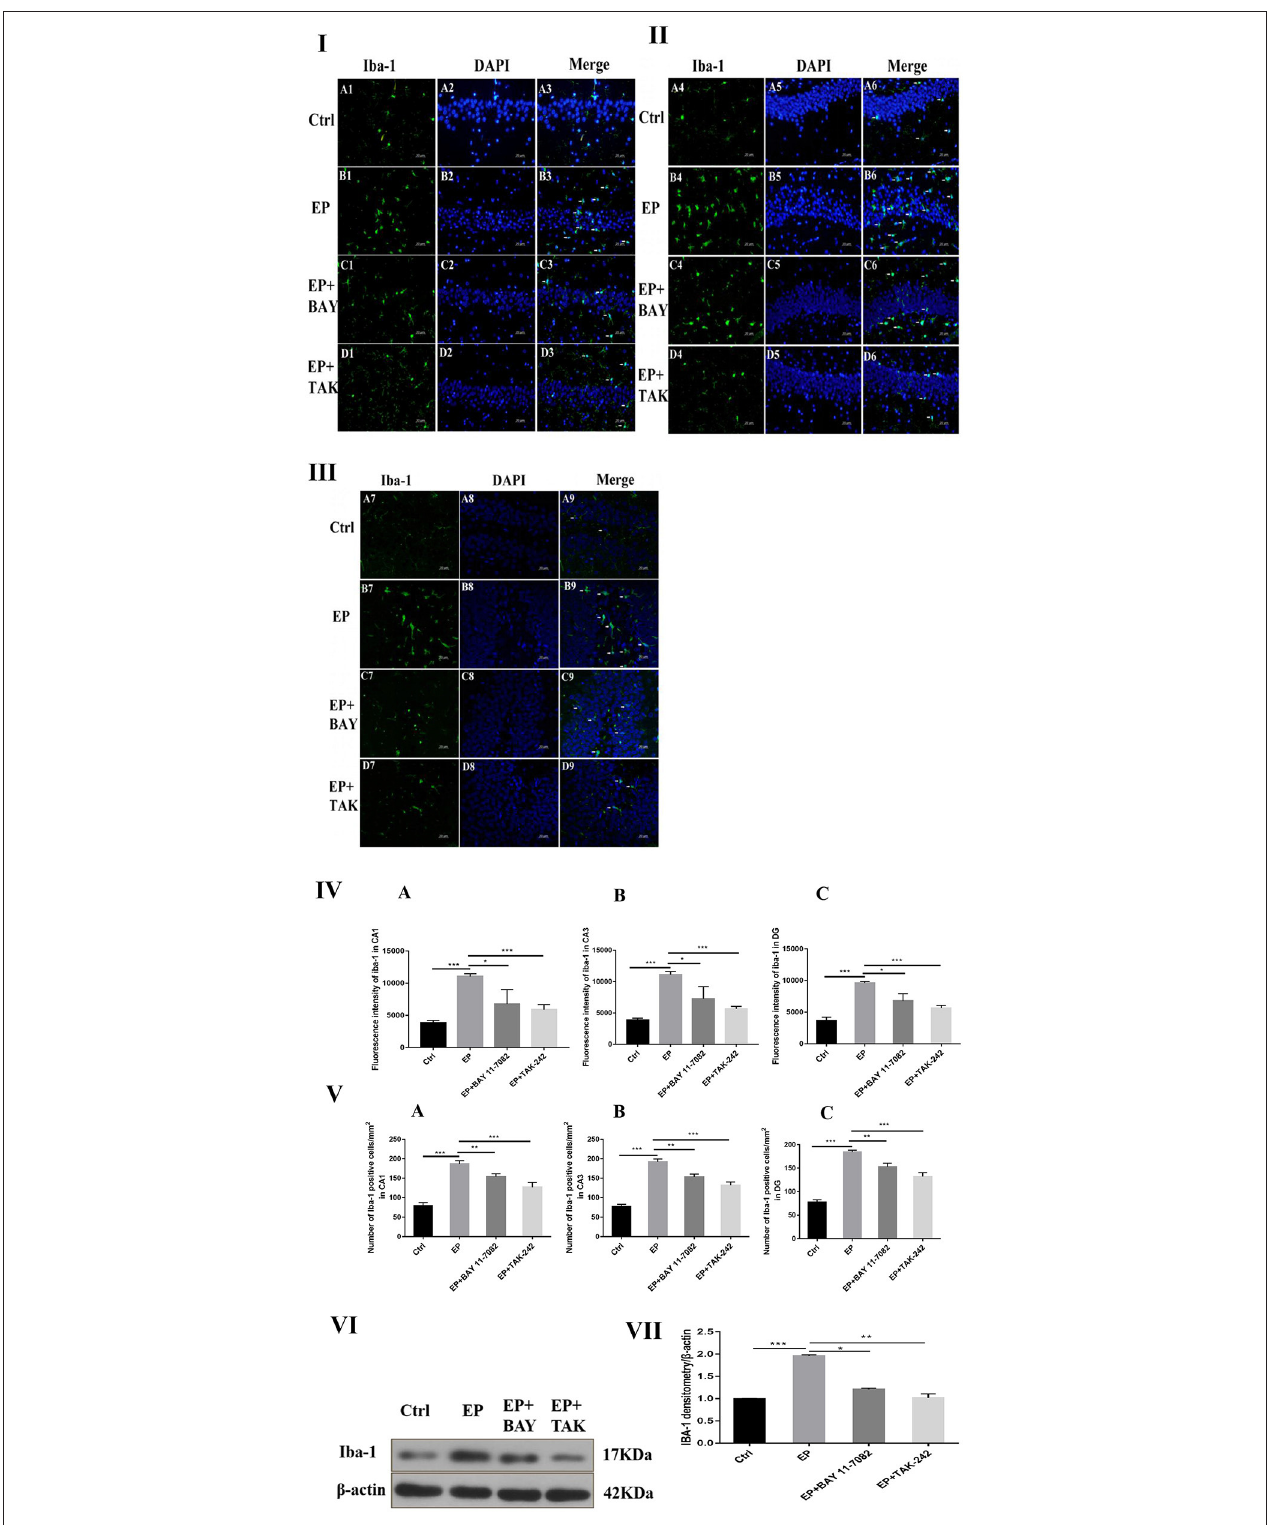
FIGURE 4 | Expression of IBA-1 protein in each group. * P < 0.05; ** P < 0.01; *** P < 0.001.